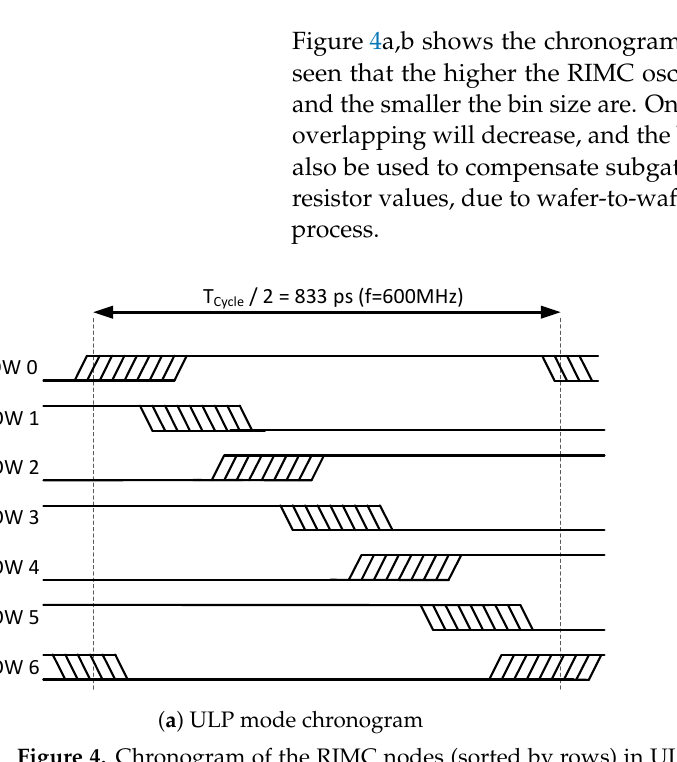
Figure 4. Chronogram of the RIMC nodes (sorted by rows) in ULP and HP modes. The phase delay between columns within the same row is static and dynamic between rows (depending on the oscillation